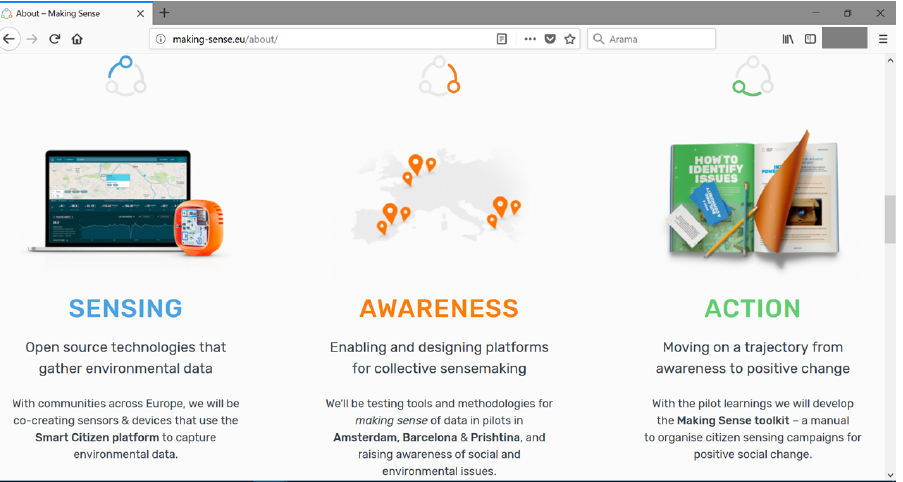
Fig. 5. Screenshot image of an online platform for open source technologies that gather environmental data. They \aim to explore how open source software, open source hardware, digital maker practices and open design can be e®ectively used by local communities to fabricate their own sensing tools, make sense of their environments and address pressing environmental problems in air, water, soil and sound pollution". 75 Such platforms are likely to be formed for open source technologies that gather health or both health and environmental (or other) data. (Image captured on 13 February 2018, irrelevant data deleted.)